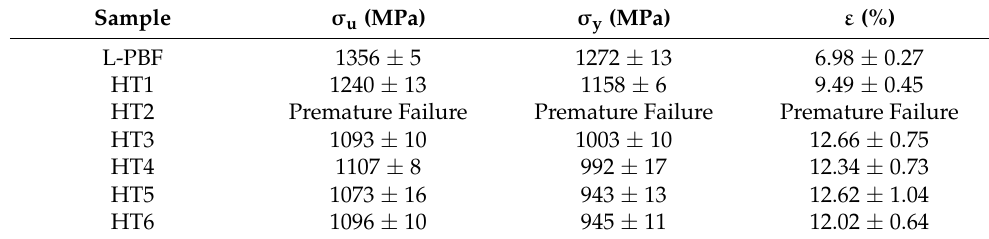
Figure 7. The mechanical properties of the as-built and annealing-treated samples. EI in the figure stands for the elongation at the break. Samples for HT2 built in a different batch in which building errors may present, which led to the observed premature failure. Table 4. Measured mechanical properties of different